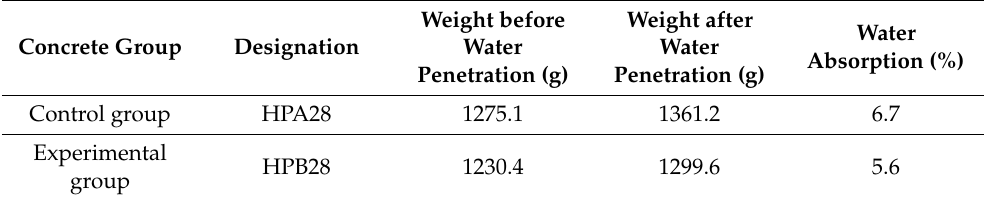
Table 28. Penetration test results of the self-healing concrete after exposure to high temperature.